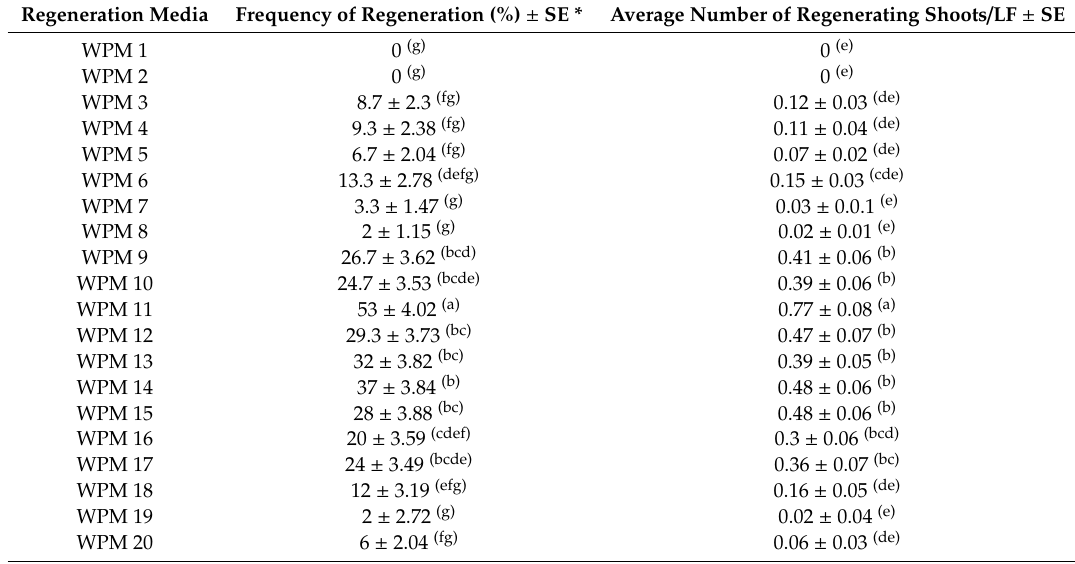
Table 1. Influence of plant growth regulators (PGRs) on the regeneration e ffi ciency from Hansen 536 leaf (LF) explants cultured for five weeks on regeneration